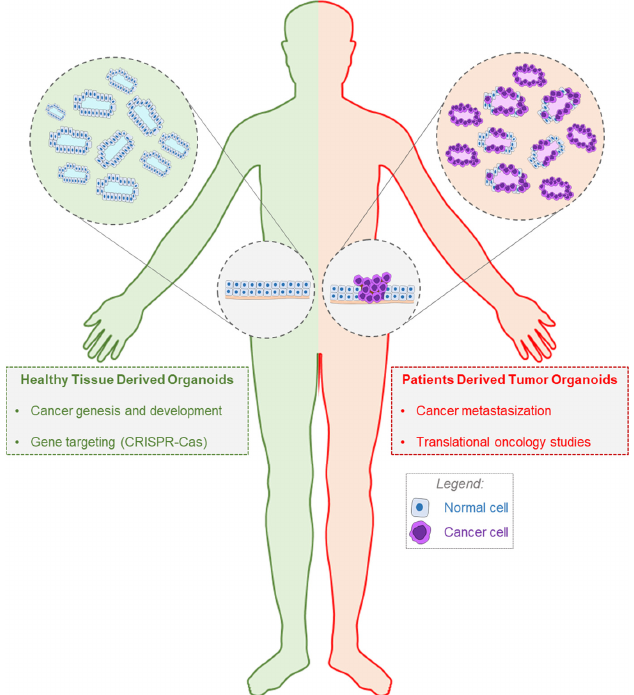
Figure 2. Types of organoids used in oncology. In cancer research, organoids either derived from healthy tissues (green box) or from cancer specimens (red box) can be employed. While, healthy organoids may be genetically modified and used to study cancer genesis and development (green box), Patients Derived Tumor Organoids (PDTOs) are valid tools to study metastasization and for translational oncology applications (red box).